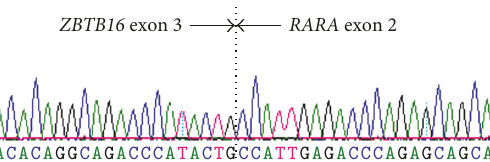
Figure 2: Sanger sequencing demonstrating fusion of ZBTB16 exon 3 to RARA exon